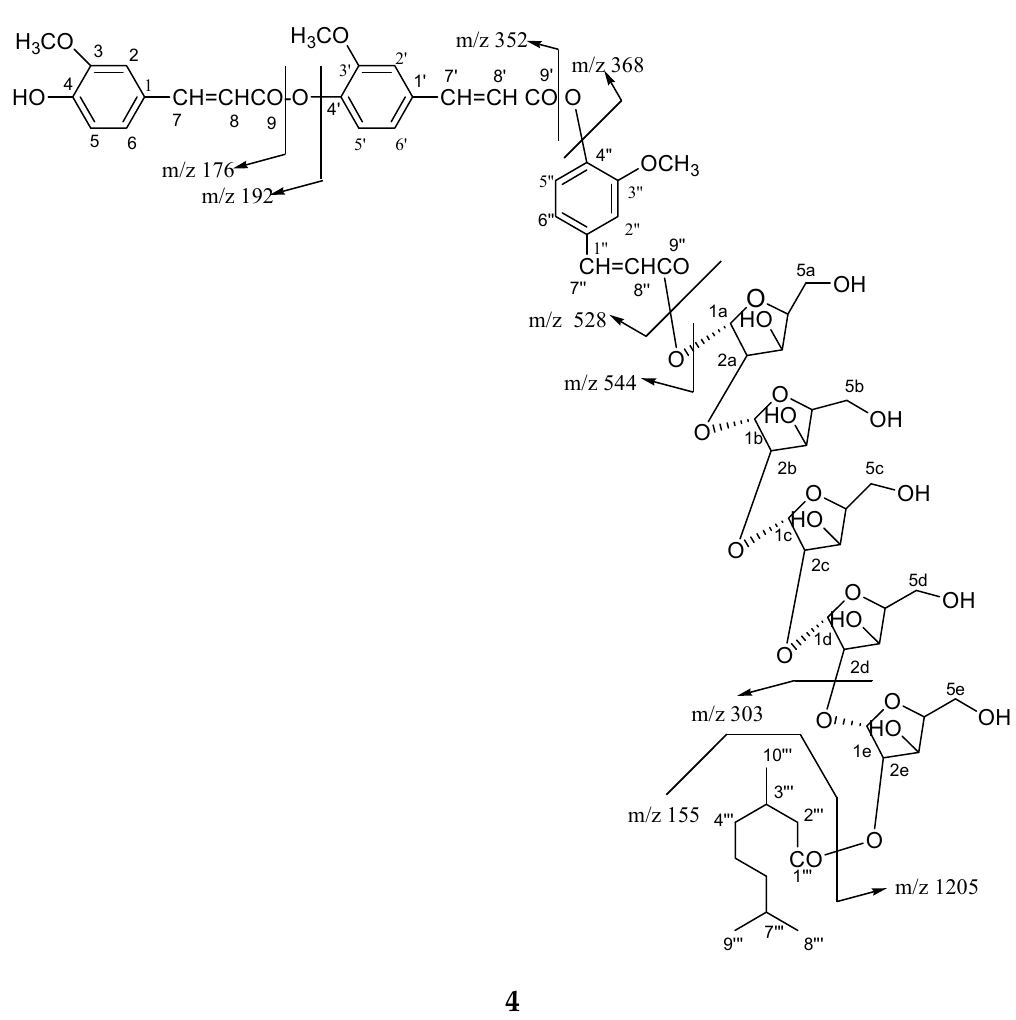
Figure 5. Fragmentation pattern of compound 4 .